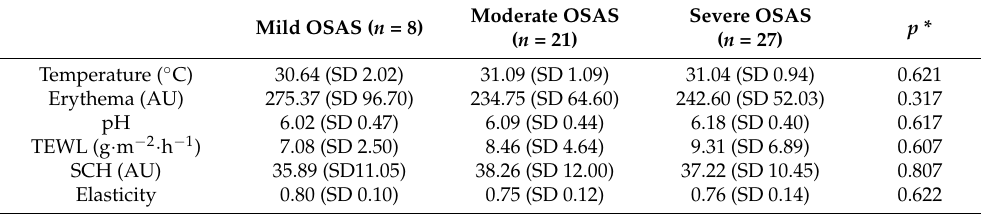
Table 3. Differences in skin barrier function in patients with OSAS depending on disease severity.